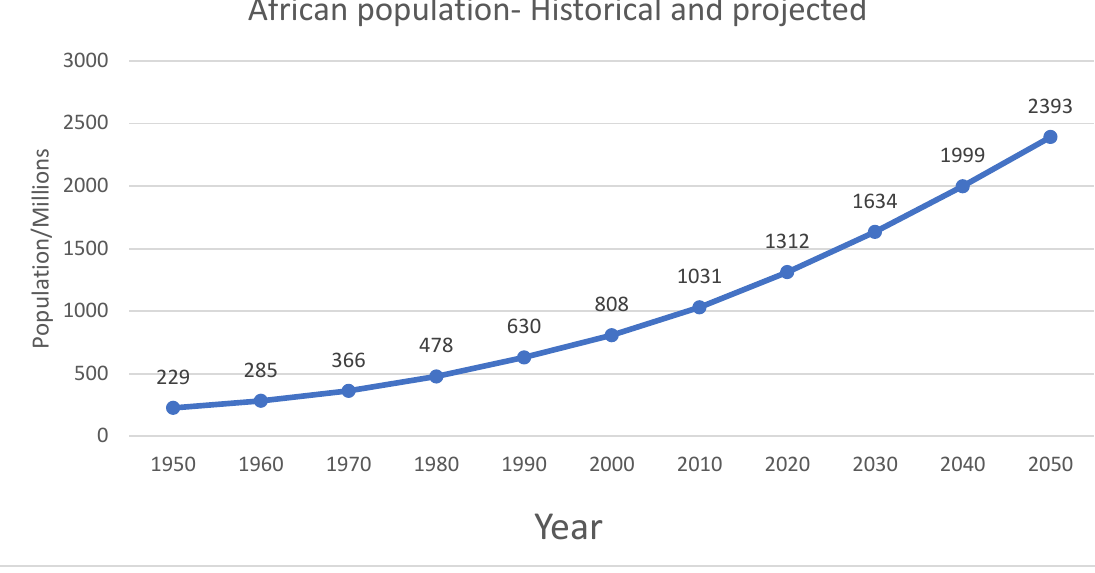
Figure 1. African population growth curve. Source: The graph was constructed using data from African Economic Outlook 2015.